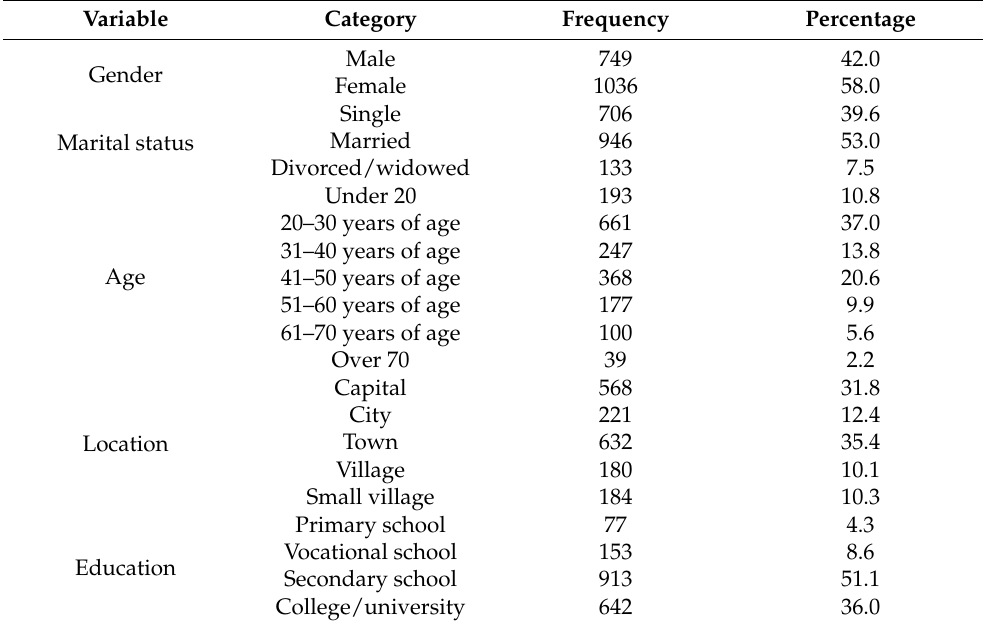
Table 4. Socio-demographic characteristics of the